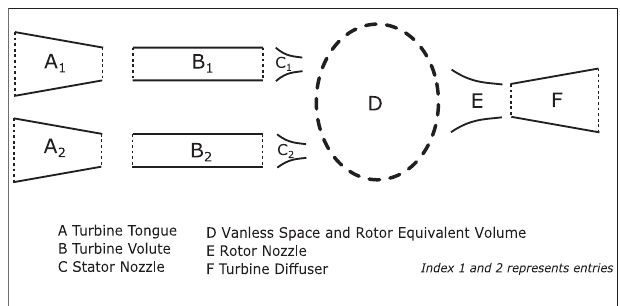
FIGURE 1 | Double entry turbine model computational